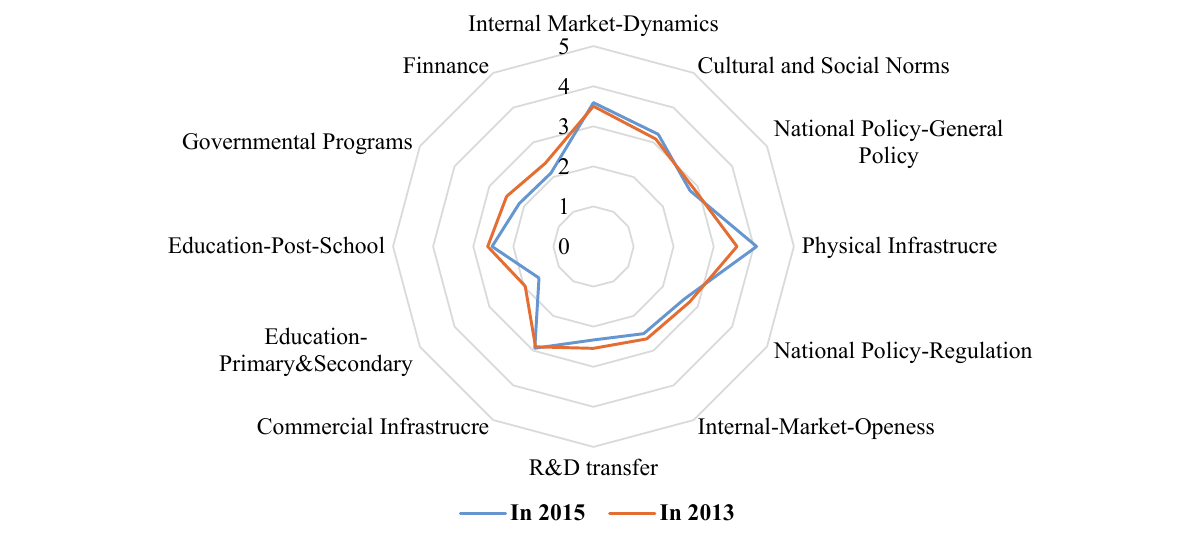
Fig.1. Conditions for entrepreneurship in Vietnam